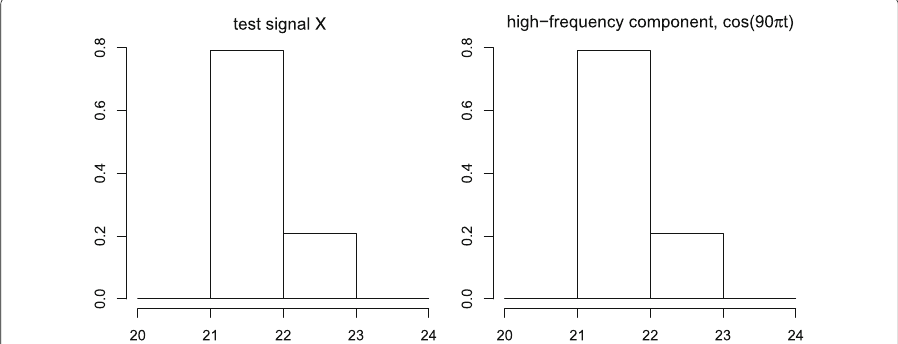
Fig. 24 The distribution of the empirical period for a signal X t = cos ( 90 π t ) + cos ( 10 π t ) and its